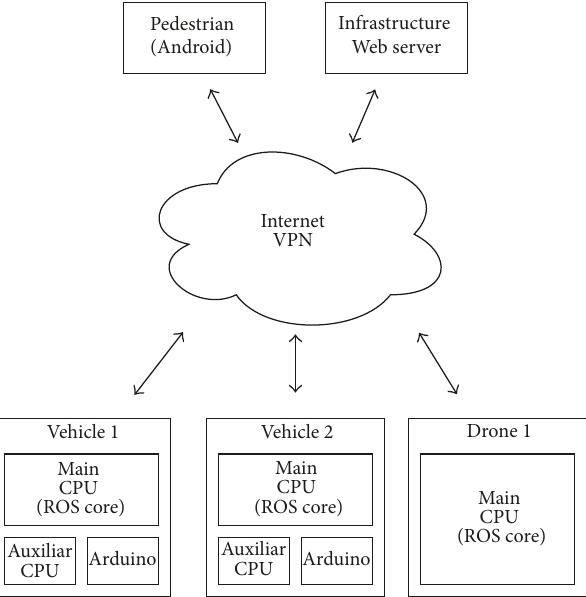
Figure 5: System